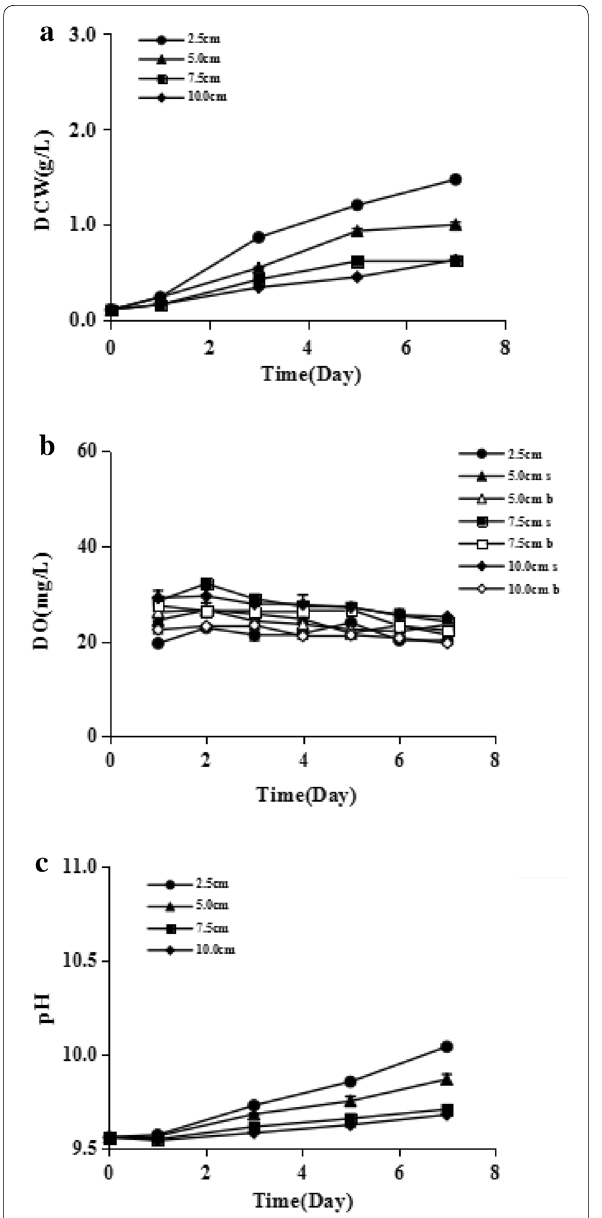
Fig. 5 Culture of Euhalothece sp. ZM001 in horizontal PBR with rocking cycle of 2 s and light intensity of 70 μmol/m 2 /s: a biomass production; b dissolved oxygen (s: surface; b: bottom); c pH change